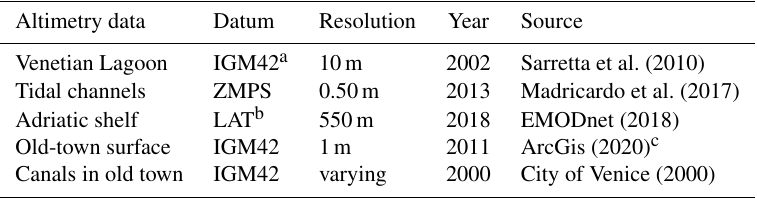
Table 2. List of altimetry data used.